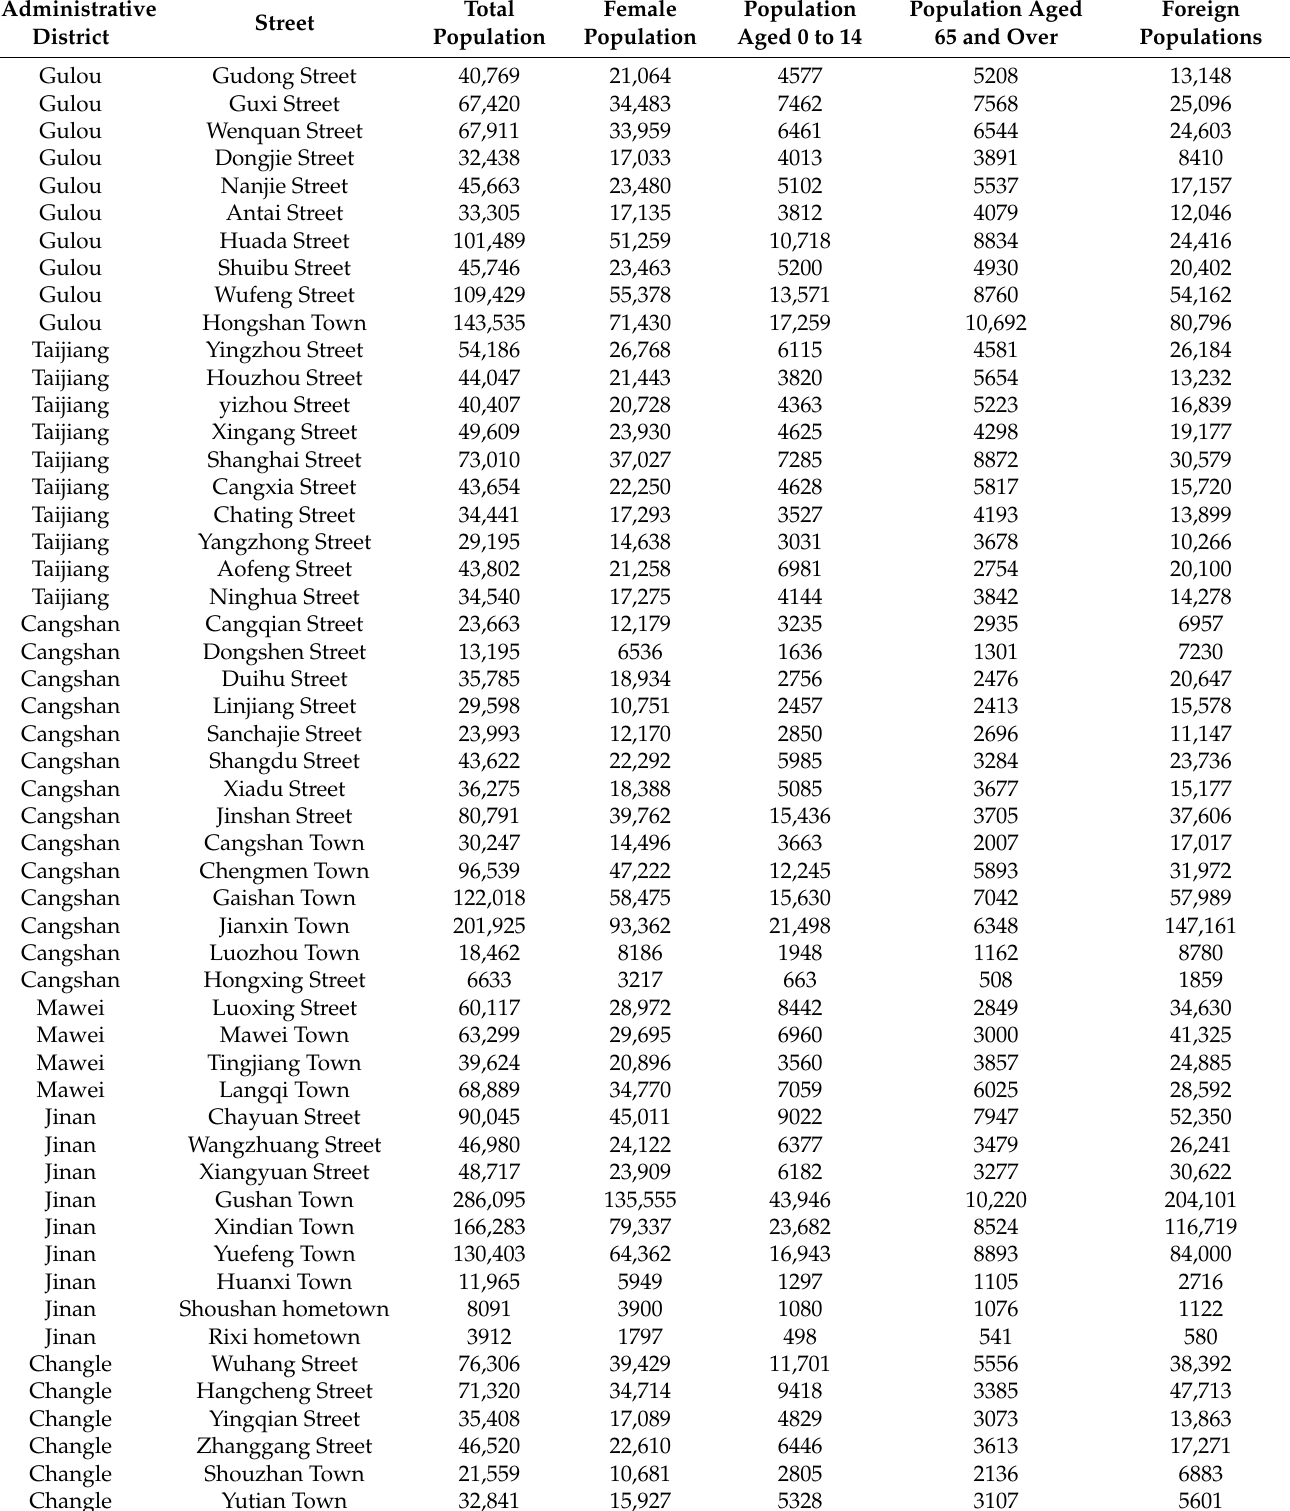
Table A1. Demographic variables in urban areas of